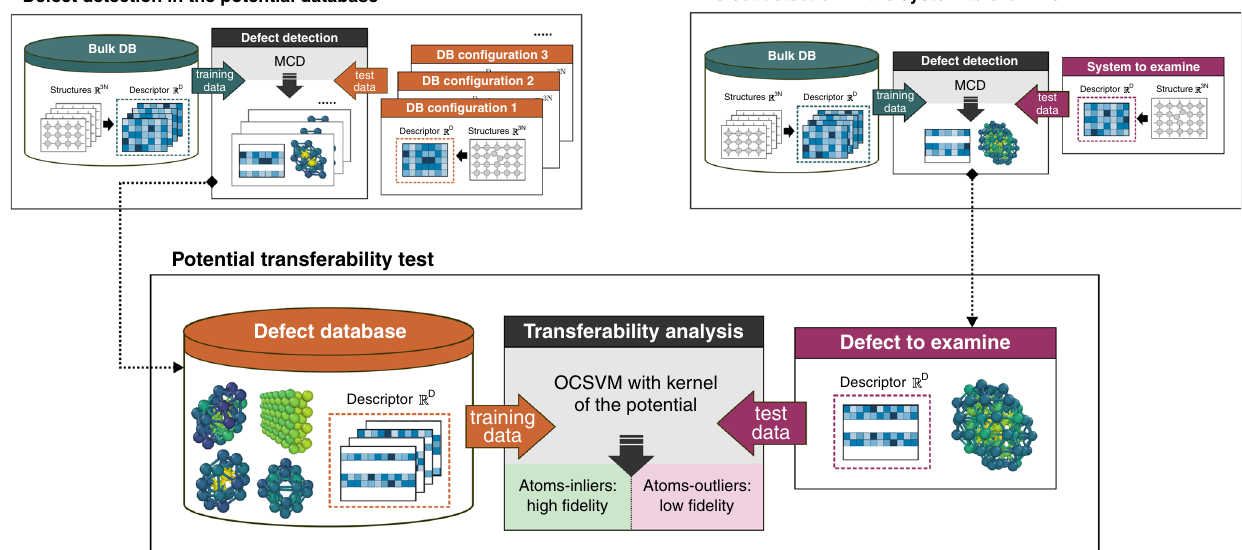
Fig. 6 Work fl ow for transferability analysis of kernel ML potentials using outlier detection. The structural data are represented in the feature space of atomic descriptor similar to that originally used to design the potential 50 . The fi rst step of the analysis (upper panel) implies detection of defects both in the potential database and in the atomic systems to examine using MCD, one-class support vector machine (OCSVM) or any other relevant method. The second step (lower panel) is aimed at transferability analysis of the potential. The detected defect clusters from the potential database form a new training data set with the structures-inliers known by the potential. The new outlier detection model is trained on these con fi gurations using a kernel method, e.g., OCSVM, with the kernel function identical to that of the tested ML potential. Identi fi cation of atoms-outliers within the examined defect cluster implies that these atomic environments are missing in the training database and, therefore, the tested ML potential may provide poor energetic properties for this